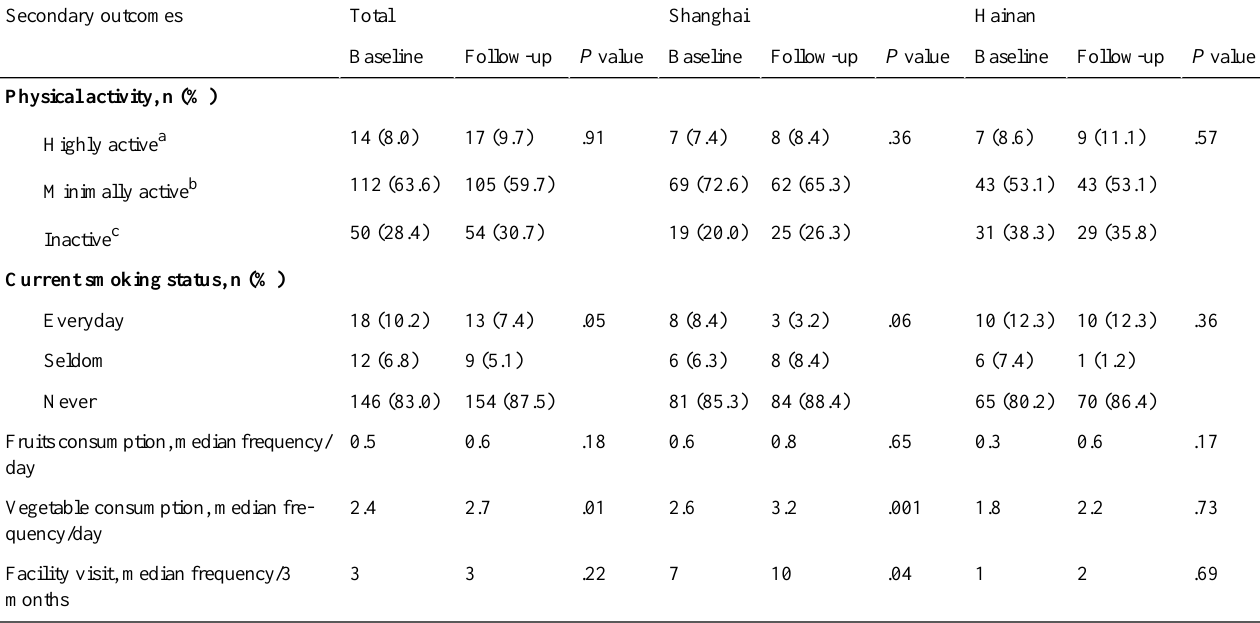
Table 3. Paired pre-post comparison of secondary outcomes. HainanShanghaiTotalSecondary